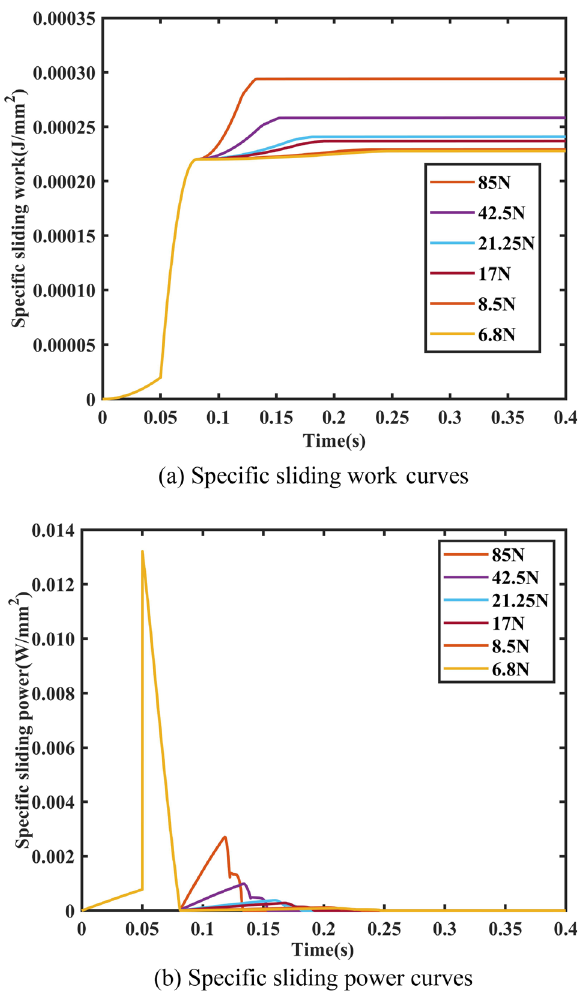
Figure 5 Using different shifting forces to directly realize position-controlled shifting Figure 6 Using different shifting forces after synchronization to achieve position-controlled